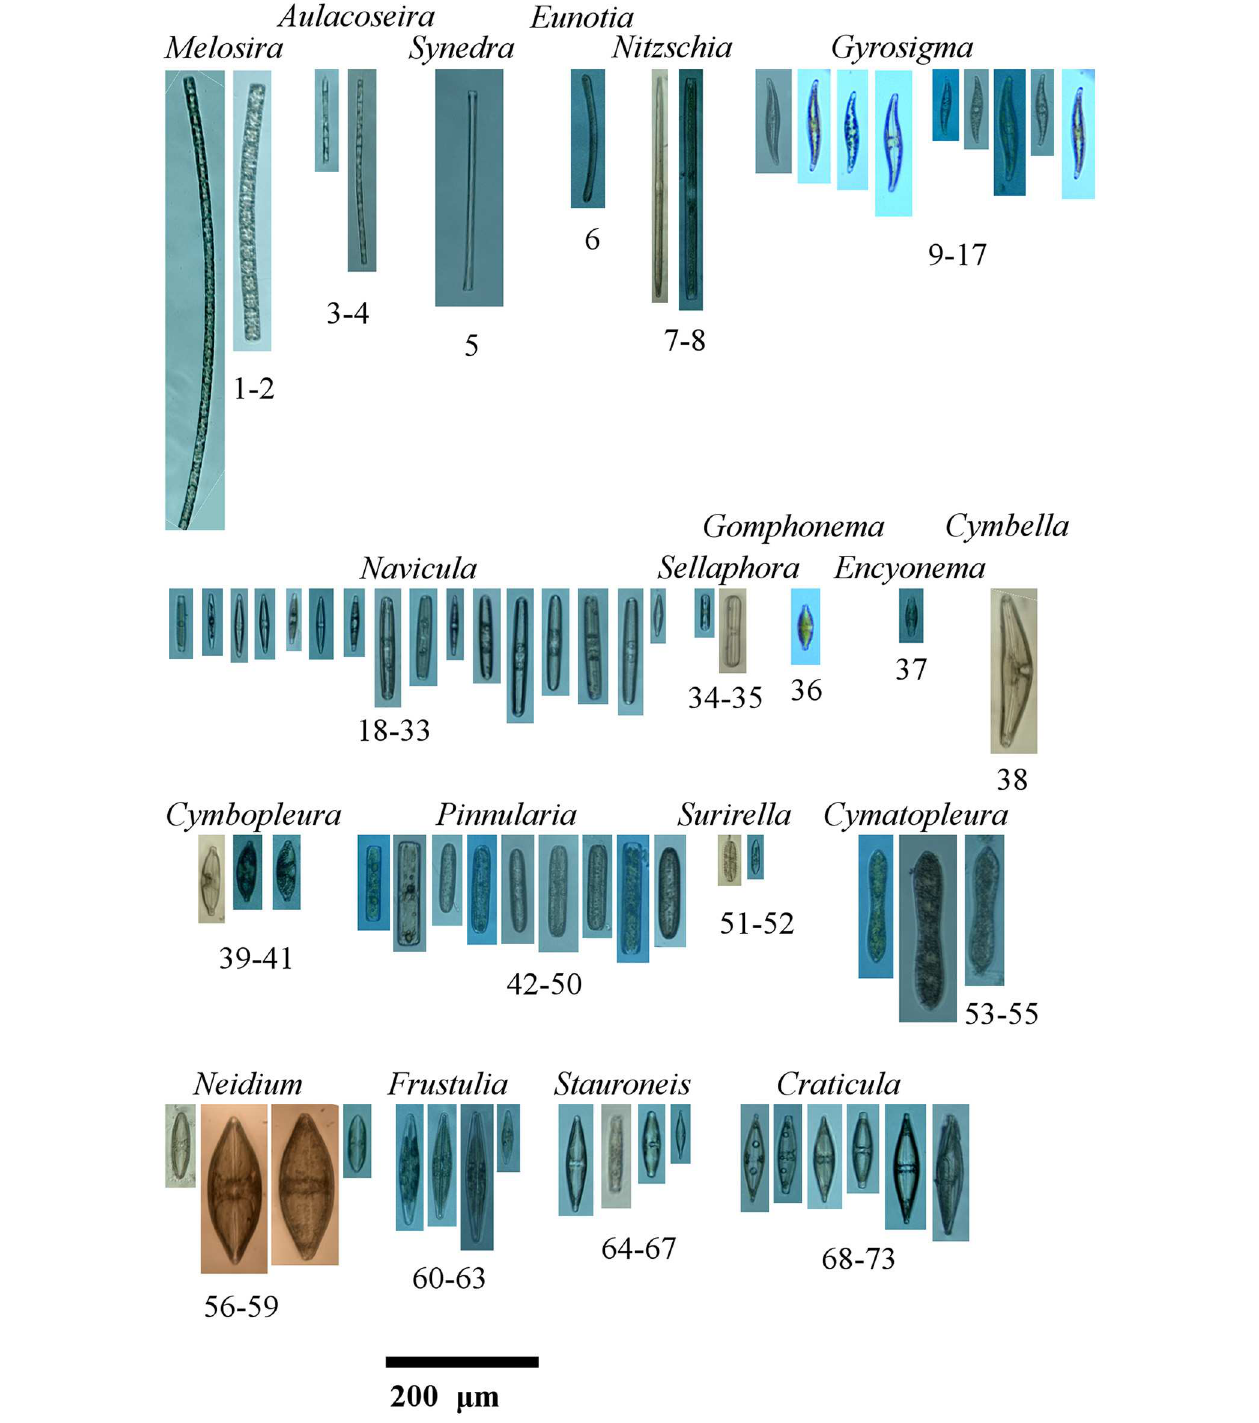
FIGURE A1 | Isolation photos of sequenced taxa aligned to their placement in Figure 2. Bolidomonas pacifica (GenBank Acquisition HQ912421.1) and Cyclotella meneghiniana (GenBank Acquisition KF959651.1) are not pictured as their sequences were used as an out group and sister group from